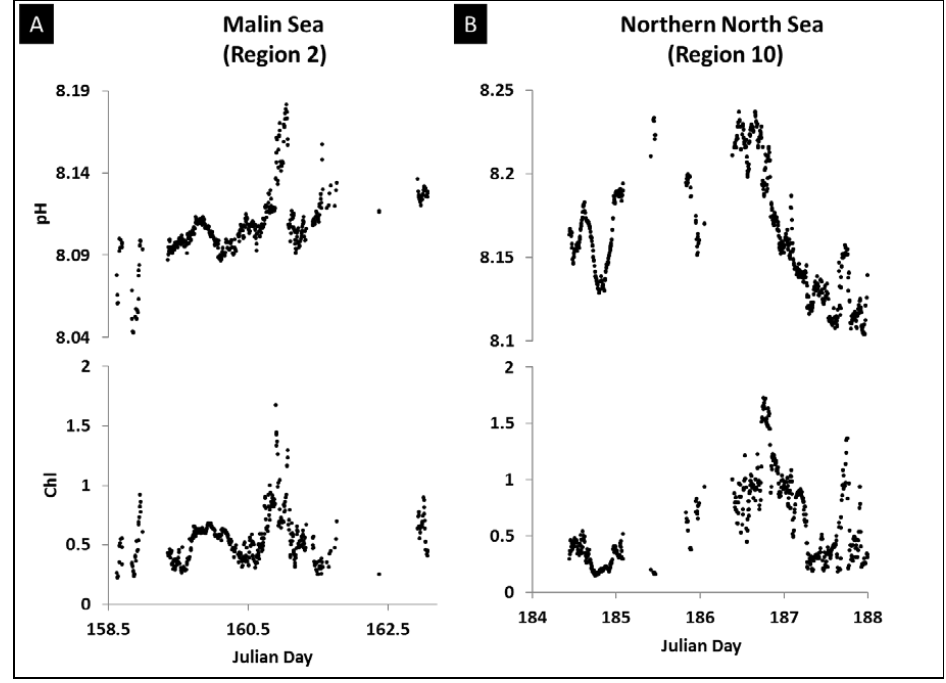
Figure 7. Observed sea surface pH and chlorophyll fluorescence (Chl) plotted against Julian day for ( A ) Malin Sea region of the North Atlantic Ocean west of Ireland (region 2), ( B ) Northern North Sea region (region 10).